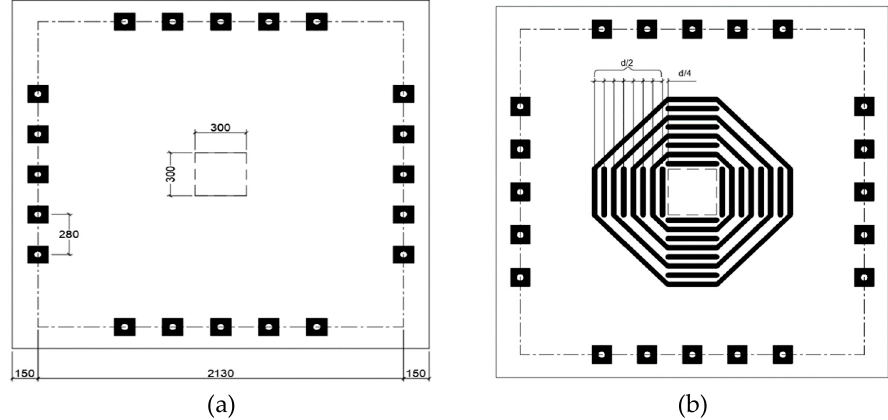
Figure 19. ( a ) Specimen dimensions, column dimensions, and locations of perimeter loading points and ( b ) 8 CFRP rows around loading column [40].